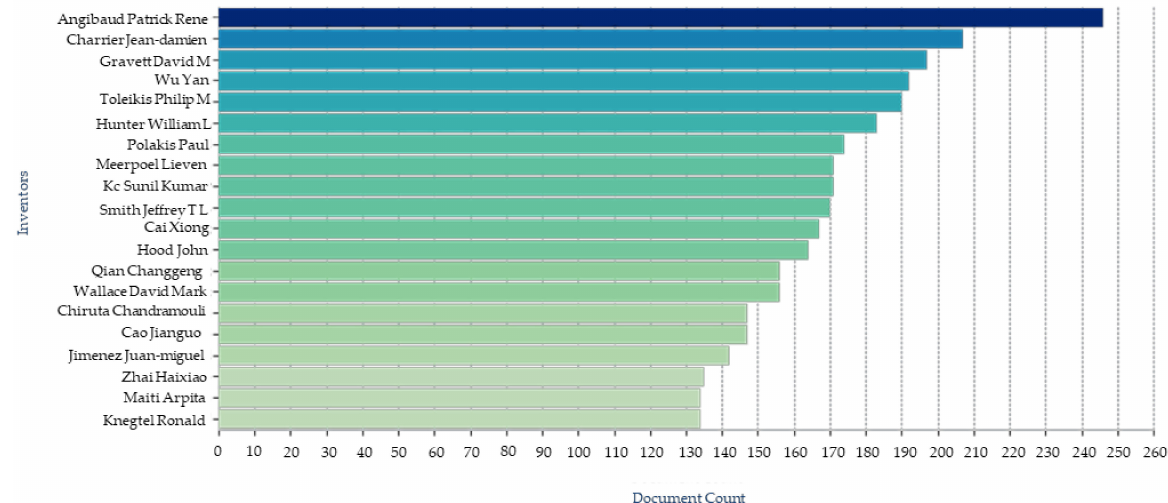
Figure 11. Key inventors in the podophyllotoxin